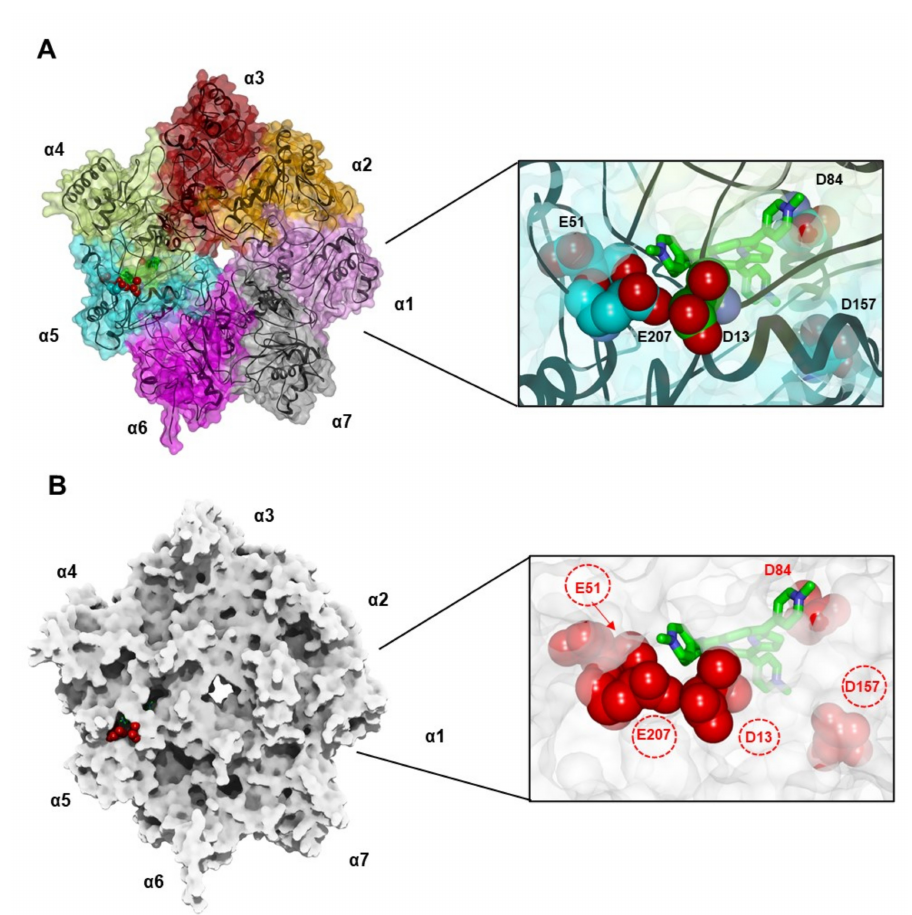
Figure 8. Selected docked complex of one TMPC molecule bound to human 20S (open conformation). ( A , B ): top and close-up view on the ligand binding site. The negative residues interacting with TMPC and those in common with Tris-T4 are displayed in CPK. ( A ) h20S backbone is displayed as black solid ribbons, while the transparent solvent accessible surface (SAS) and the displayed residues are colored in pink ( α 1), orange ( α 2), brown ( α 3), light green ( α 4), cyan ( α 5), magenta ( α 6), and gray ( α 7). TMPC is colored by atom type (C: black; N: blue; O: red), and its solvent accessibility surface is displayed (green). ( B ) h20S SAS is displayed as solid and colored in white. TMPC is colored by atom type (C: green; N: blue; O: red) and displayed in stick. The h20S interacting residues are colored in red. The negatively charged residues involved in ionic interactions with RPs are evidenced with a red dashed